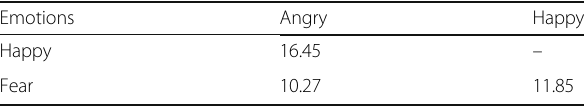
Table 8 Confusion degree between angry, happy, and fear (%)